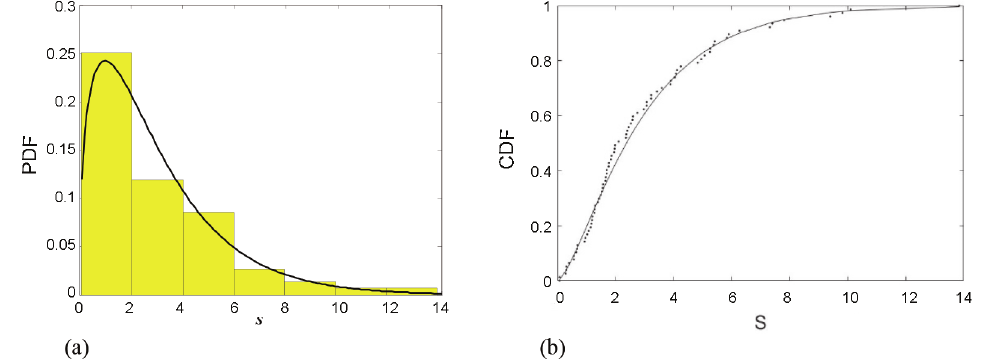
Figure 4. (a) Histogram of S compared with the PDF of 2 3 χ distribution, (b) P-P plot of S compared